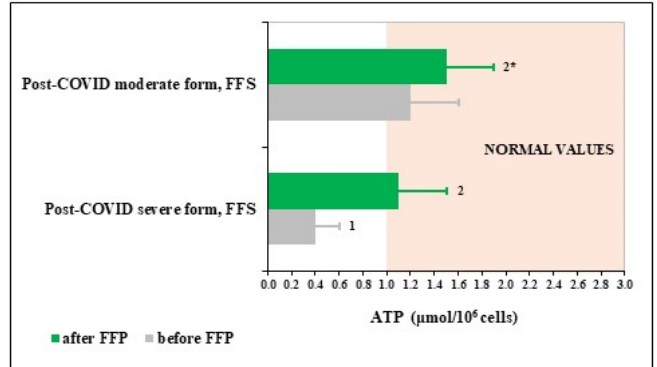
Figure 2. Polymorphonuclear leukocyte (PMN) levels of ATP in post-COVID period of the Fermented Fruits Supplemented (FFS) groups. Area coloured in beige covers normal range of values. 1 p < 0.01 versus normal values; 2 p < 0.01 versus post-COVID severe form; 2 * 0.05 < p < 0.1 versus post-COVID moderate form group before FFS